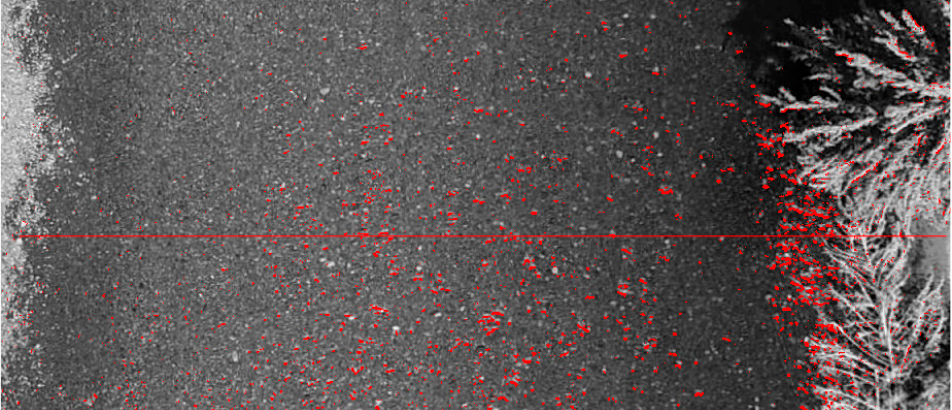
Figure 5. A part of a frame from the Salmon River video; the surface velocities are estimated along the displayed red line. The flowing features (ripples) are colored red.